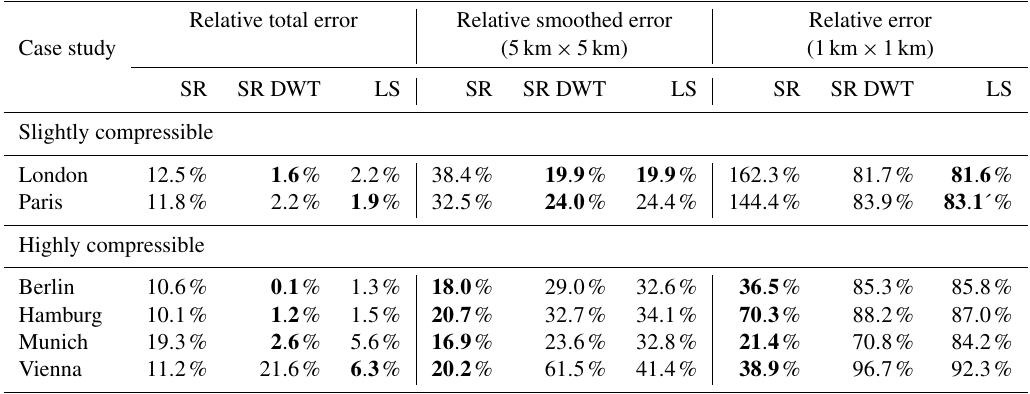
Table 4. Reconstruction performances for SR in the spatial and wavelet domain as well as for LS by using m for different European cities. The results are evaluated using the relative error (1km × 1km), relative smoothed error (5km × 5km), and the relative total error. The best approach for each city and type of error is highlighted in